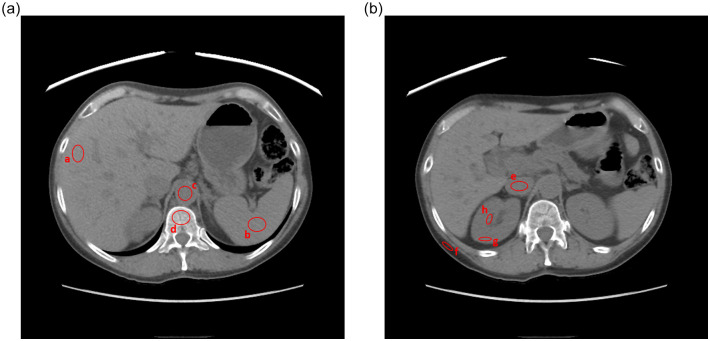
Typical region of interest (ROI) placement for the quantitative analysis.a) liver; b) spleen; c) aorta; d) spine; e) inferior vena cava (IVC); f) subcutaneous fat; g) renal cortex; h) renal medulla.